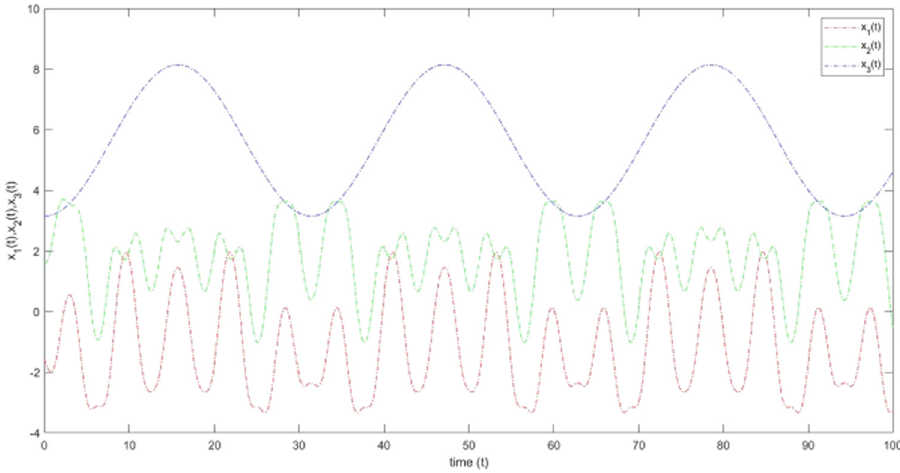
Figure 2: The solution of systems ( 40 ) – ( 42 ) ( without control )